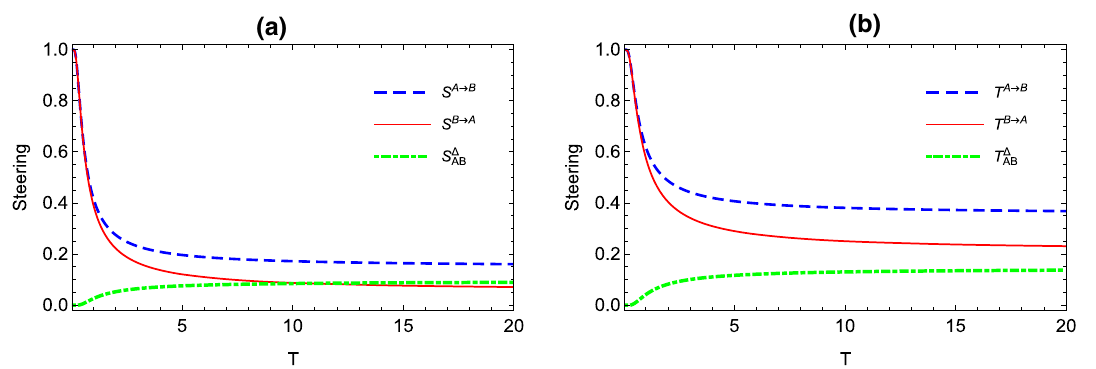
Fig. 1 The fermionic steerability and steering asymmetry between Alice and Bob as functions of the Hawking temperature T . The parameter ω is fixed as ω =